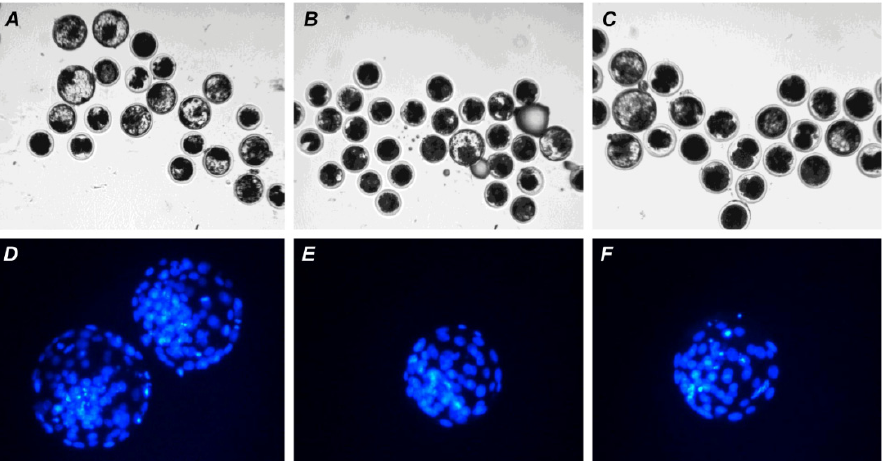
Figure 10. Representative images of embryos (day 7) derived from in vitro-matured or aged bovine CEOs. ( A , D ) Oocytes were fertilized immediately after IVM. ( B , E ) Oocytes were fertilized following 12 h of aging in the control medium. ( C , F ) Oocytes were fertilized following 12 h of aging in the medium containing PRL. ( A – C ) The morphology of IVP blastocysts. Original magnification: × 100. ( D – F ) The nuclear state of IVP blastocysts, DAPI staining. Original magnification: ×